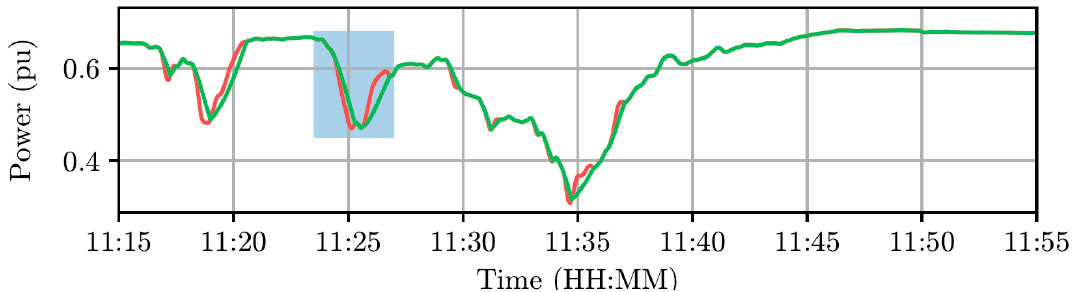
Figure 4. Output power (red: actual; green: smoothed) of a 239 kW p PVPP with 1 s resolution [28]. The shaded area in Figure 4 is enlarged in Figure 5 where the PV power is shown in red, while the smoothed electrical power in green. The PV power is the power determined by the maximum power point tracking (MPPT) algorithm of the PVPP. The smoothed electrical power is achieved by using a FSS (an ultracapacitor bank) in the DC link of the PV converter and by implementing the smoothing algorithm developed in [28] that limits the ramp rate to ± 20% · P N,DRES /min .